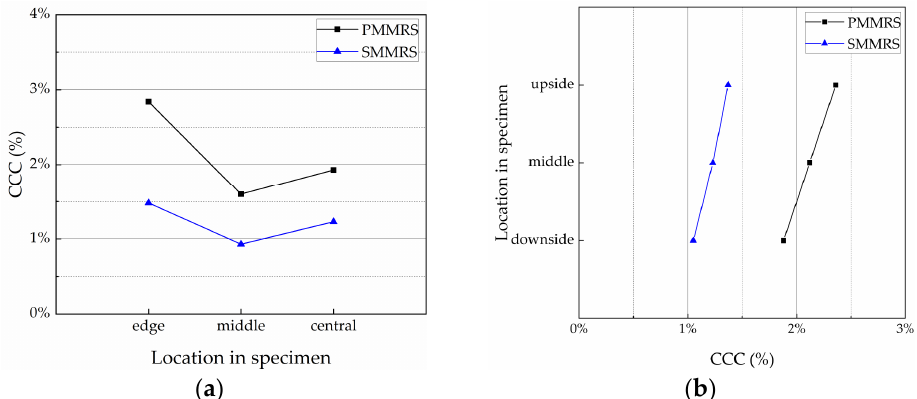
Figure 9. CaCO 3 distribution in PMMRS and SMMRS: ( a ) lateral direction and ( b ) vertical direction.